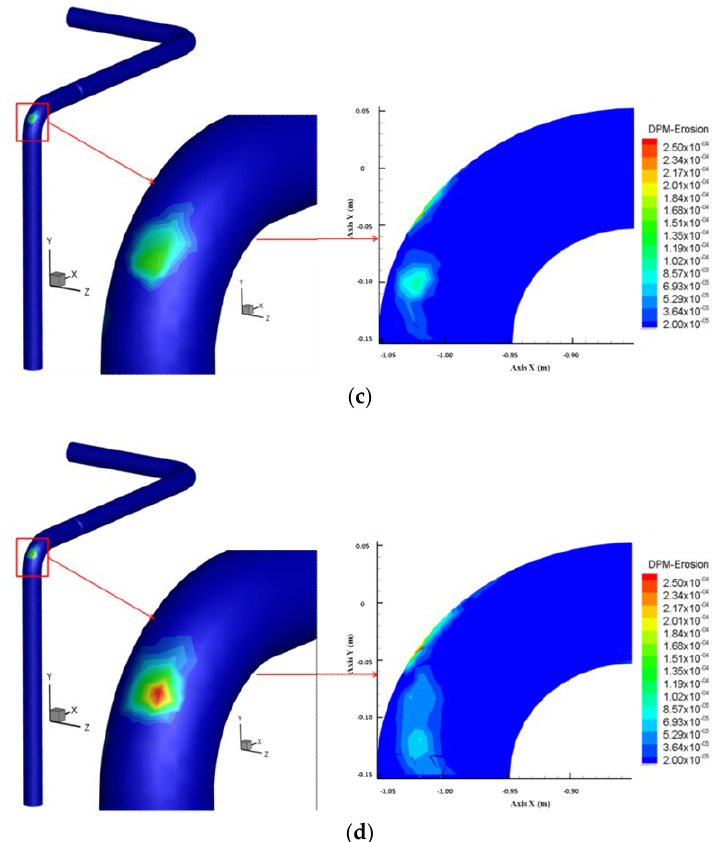
Figure 8. Erosion rate contours of gas–solid two-phase flow pipeline under different solid content values. ( a ) solid content being 2.0 kg ( M = 2.0 kg); ( b ) solid content being 3.0 kg ( M = 3.0 kg); ( c ) solid content being 4.0 kg ( M = 4.0 kg); ( d ) solid content being 5.0 kg ( M = 5.0 kg).